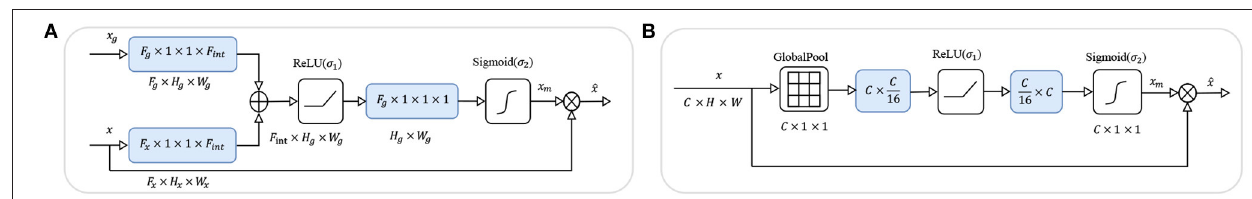
FIGURE 4 | The structures of the two attention modules. In the figures above, blue boxes represent the convolutional layers, and represents the spatial-wise reweight in (A) and channel-wise reweight in (B) N